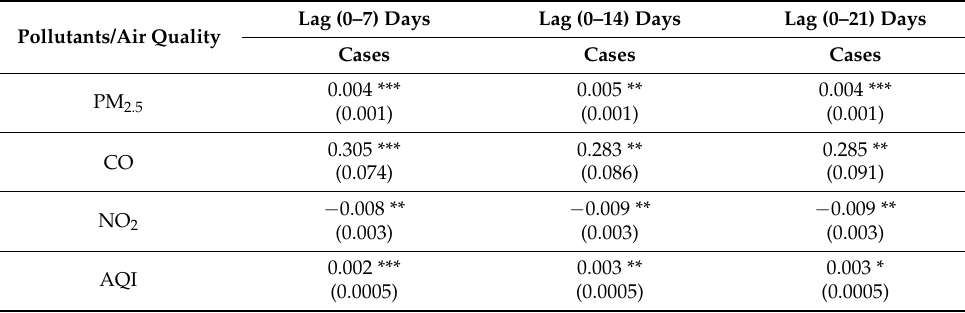
Table A4. GAM after excluding ( cases it- 1 ) of previous cases of COVID-19 from the model.